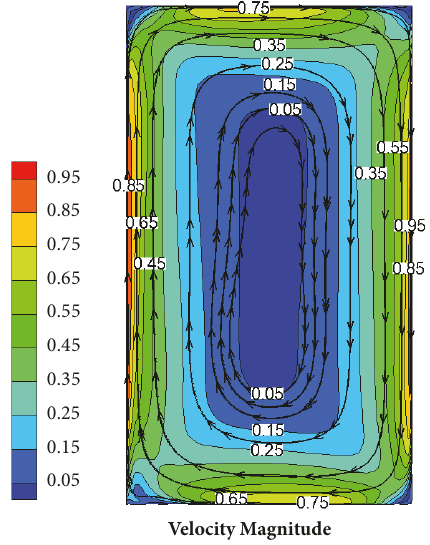
Figure6:Gasmixturevelocitycontourandstreamlinesinthescaled AP600